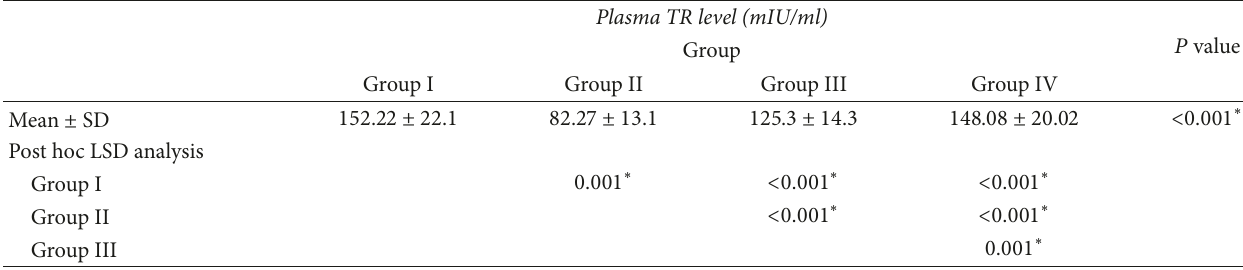
Table 4: One-way ANOVA statistical analysis of plasma TR level in different experimental groups (𝑛 = 10) .